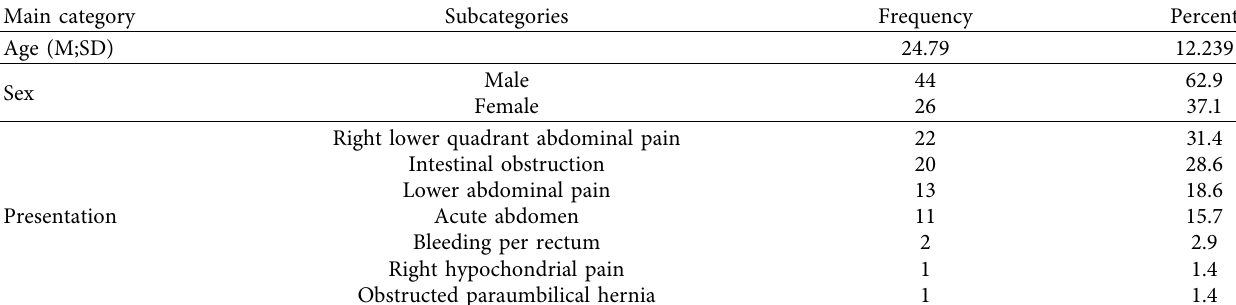
Table 1: Showing the characteristics of the participants and the various types of presentations.